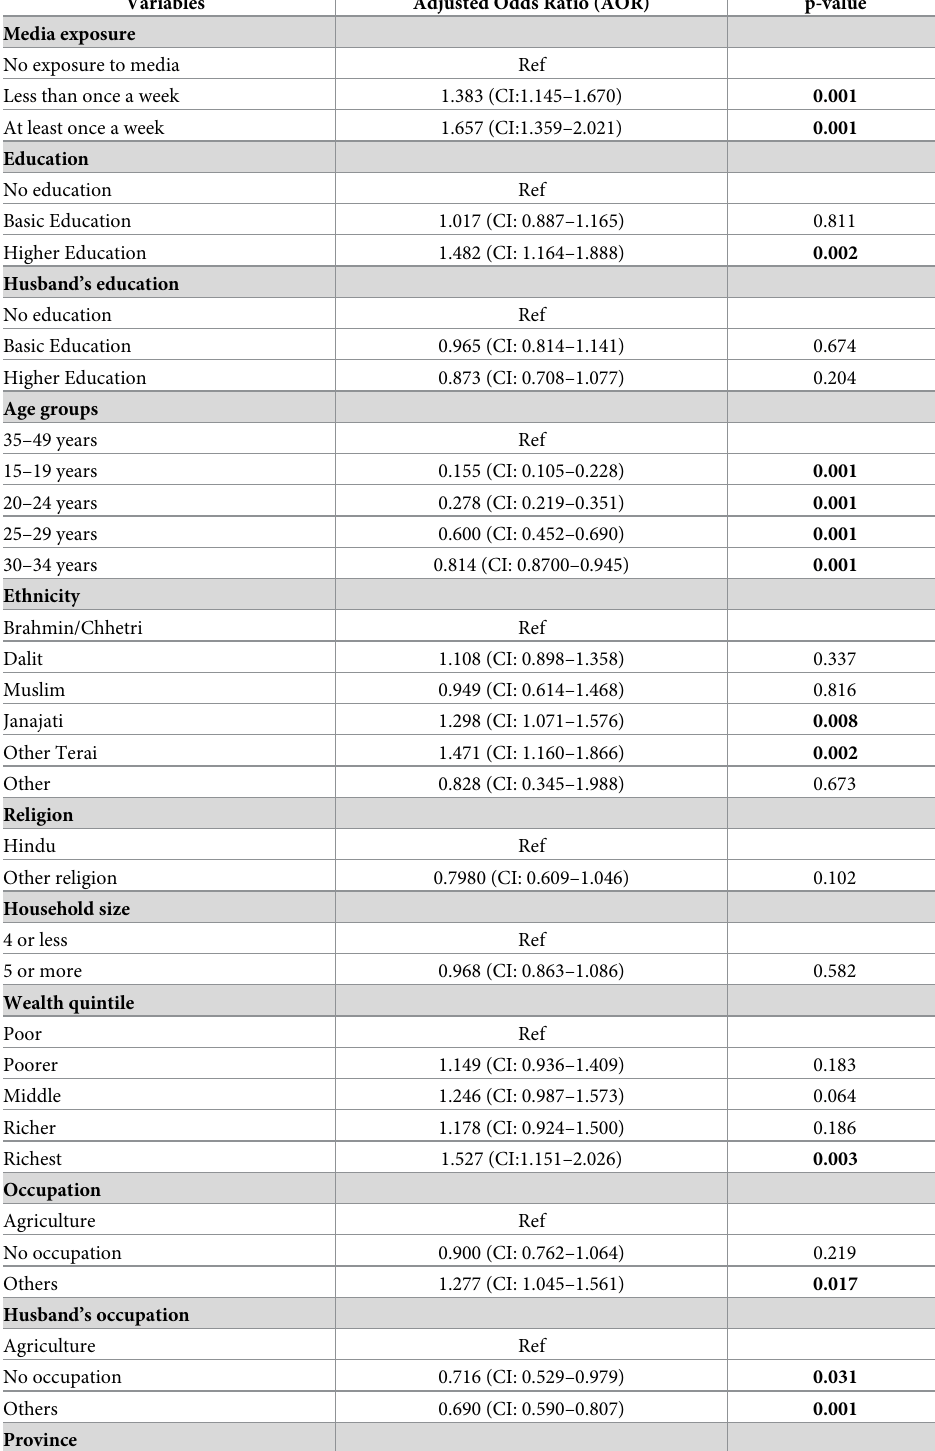
Table 6. Results from a multivariate logistic regression analysis of women’s autonomy in decision-making and exercise of their